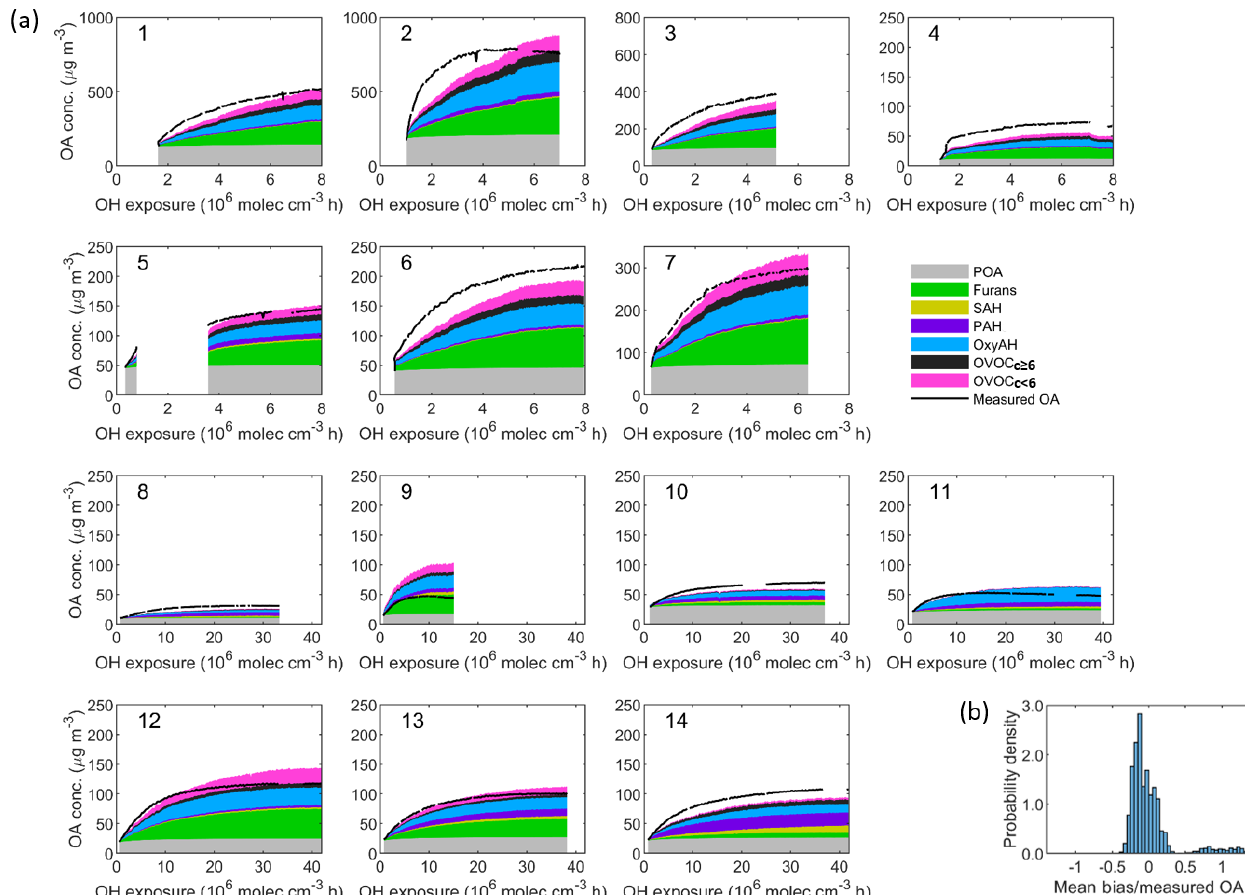
Figure 7. (a) Comparison between the sum of simulated organic aerosol (OA) concentrations from different precursor families and the measured OA concentration as a function of the OH exposure for each smog chamber experiment. Set 1 (Expt. 1–7, 2 ◦ C) and Set 2 (Expt. 8–9, − 10 ◦ C and Expt. 10–14, 15 ◦ C). (b) Probability distribution of mean bias weighted by the average measured OA concentration. The resulting mean bias is − 7 . 2µgm − 3 ( ∼ 15%) and the root-mean-square error (RMSE) is 37.4µgm − 3 . The model tends to underestimate the measured OA for Set 1 with a mean bias of 7% while it tends to overestimate the measured OA for Set 2 with a mean bias of